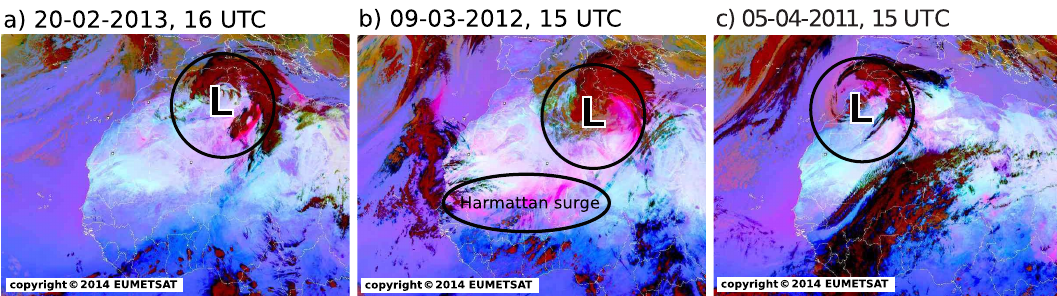
Figure 1. Observations of cyclones and associated dust aerosol over North Africa. Shown are false-colour images from MSG-SEVIRI (e.g. Schepanski et al., 2007) indicating mineral dust aerosol (pink) and clouds (red and black). Circles and ellipse mark the cyclone-affected area with a radius of 10 ◦ and dust emission associated with a Harmattan surge, respectively.